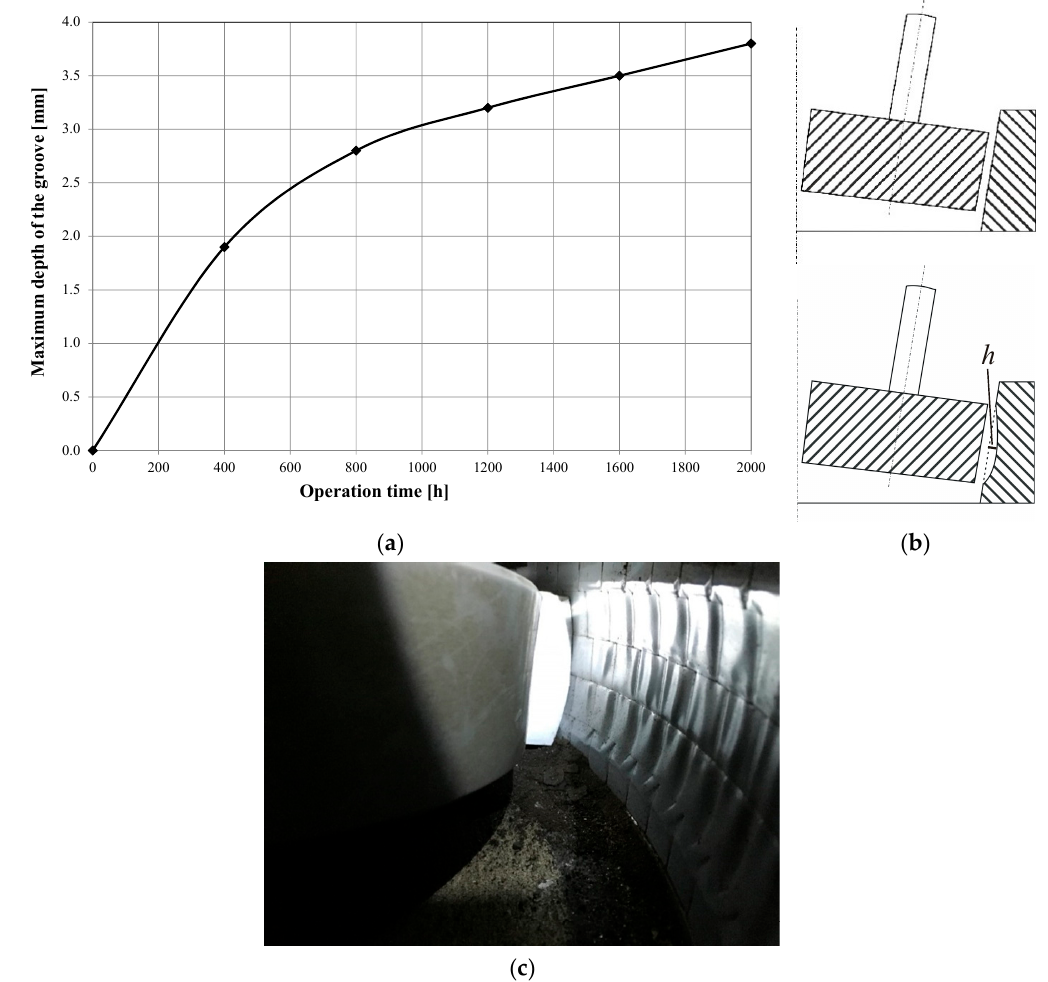
Figure 1. Wear of regenerator batch lining as a result of long-term operation, measurement at constant supply pressure set as p = 2.4 bar: ( a ) maximum depth of side surface groove (marked by h in drawing ( b )) as a function of regenerator work time; ( b ) scheme of regenerator batch lining wear; ( c ) photo showing regenerator batch lining wear.